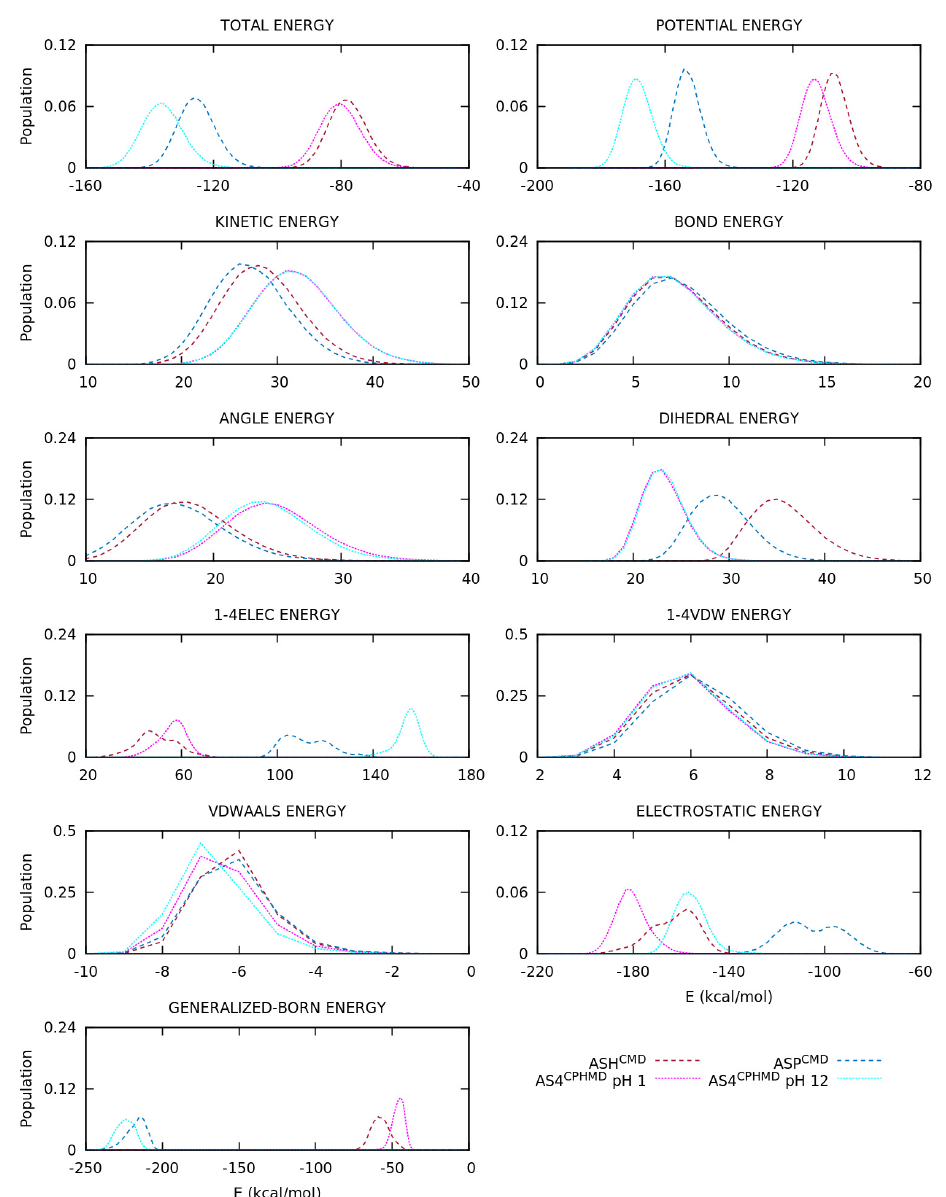
Figure 9. Energy distributions of the blocked Asp 2 tripeptide. Global, inner, van der Waals, and electrostatics terms are illustrated. Dotted and dashed lines are CPHMD and CMD simulation methods, respectively.